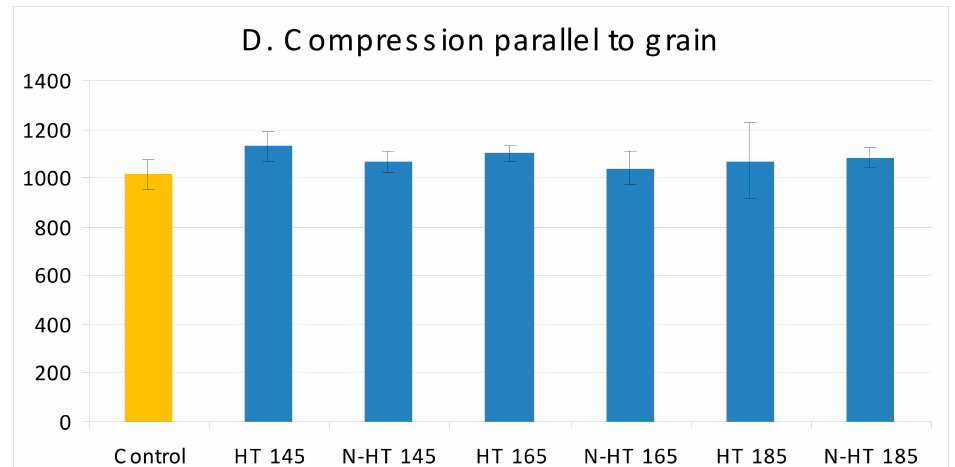
Figure 4. Mechanical properties in beech wood heat-treated at 145, 165, and 185 ◦ C and impregnated with silver nano-suspension (HT = Heat Treatment at a determined temperature; N = nanosilver impregnated).